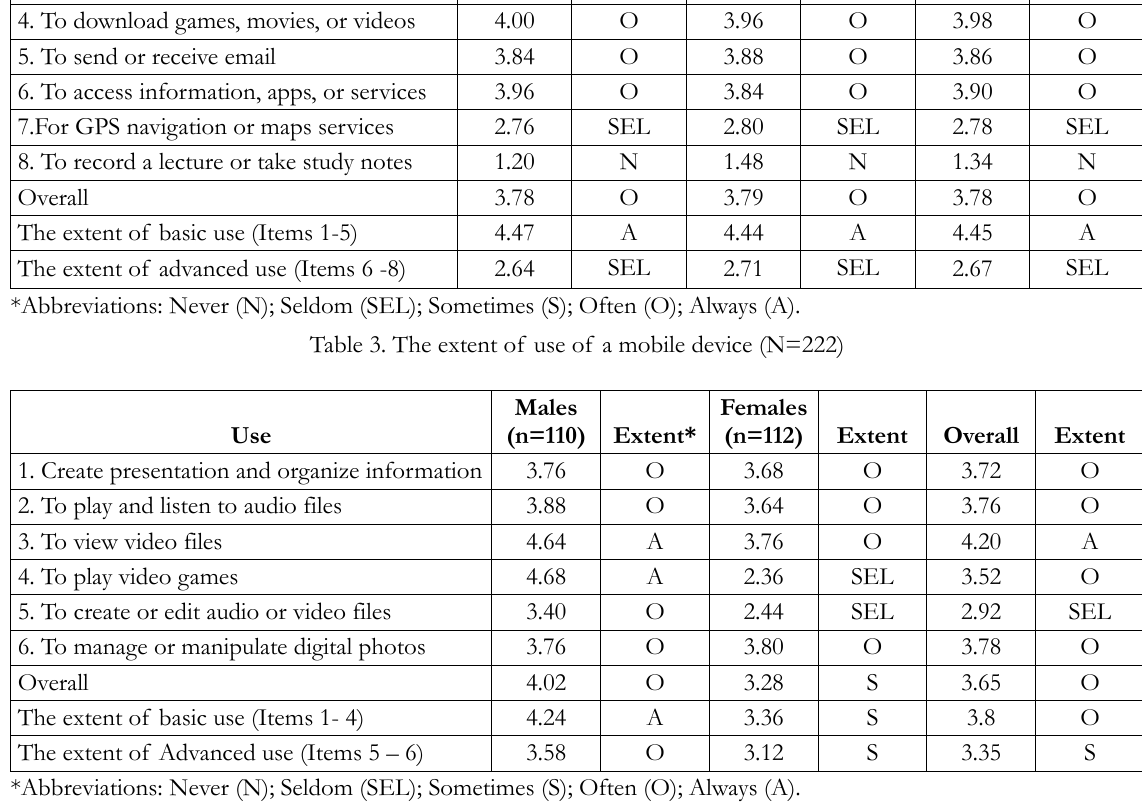
Table 4. The extent of the use of computers